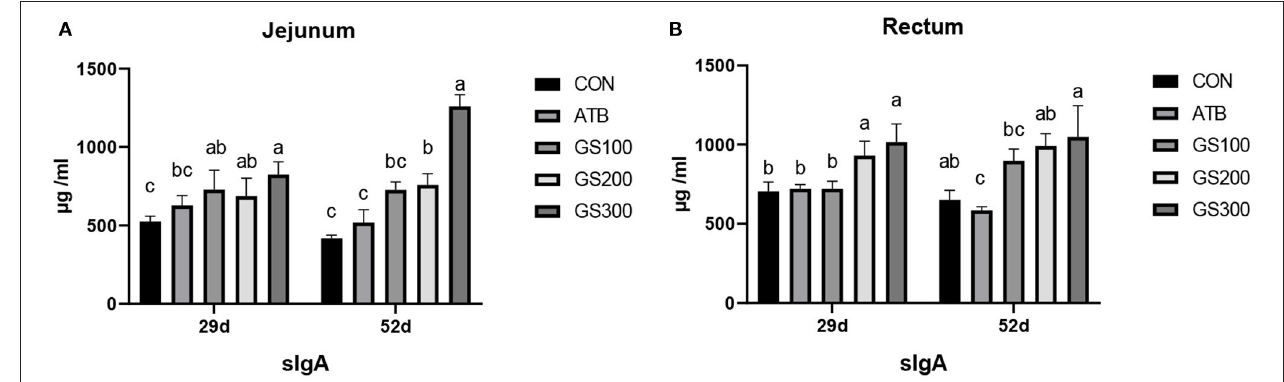
FIGURE 5 | Effects of Ginsenoside Rg1 on the content of secreted Immunoglobulin A in jejunum (A) and rectum (B) in broiler chickens ( n = 6). CON, birds fed a basal diet; GS100, birds fed a basal diet supplemented with 100 mg/kg ginsenoside Rg1; GS200, birds fed a basal diet supplemented with 200 mg/kg ginsenoside Rg1;